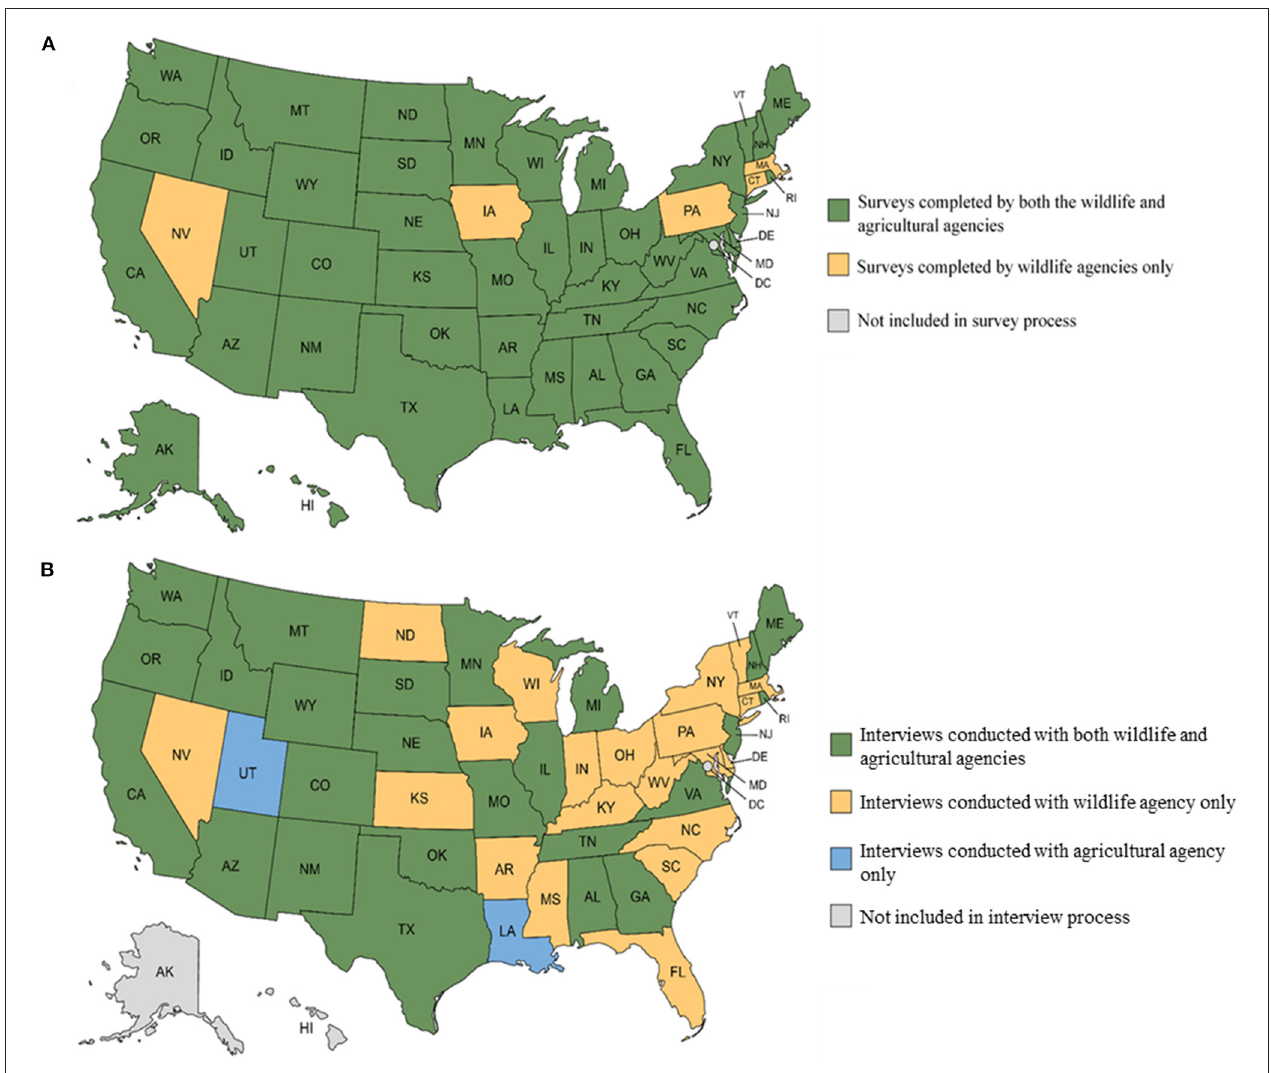
FIGURE 2 | Distribution of completed (A) online surveys and (B) semi-structured interviews of wildlife and agricultural agencies across the United States, 2021. Created with mapchart.net.